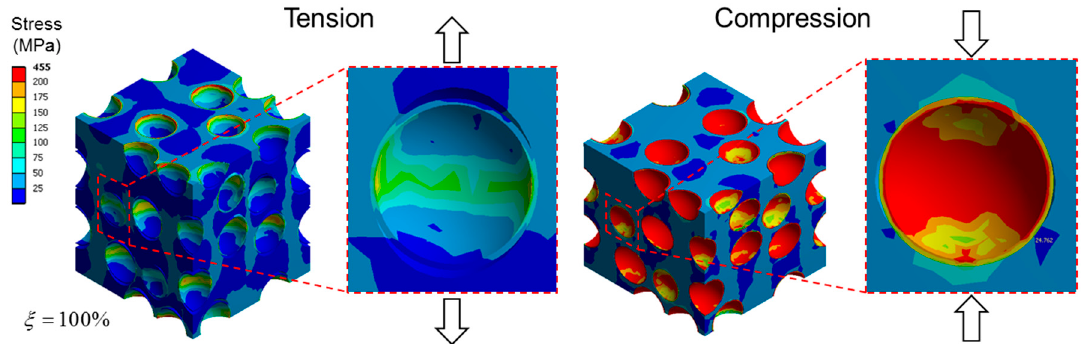
Figure 6. Equivalent stress fields at 1% tensile and compressive loads for the mixed model, with ξ = 100% which is complete debonding for all microspheres. Strains are magnified by a factor of 10 for better visualization.